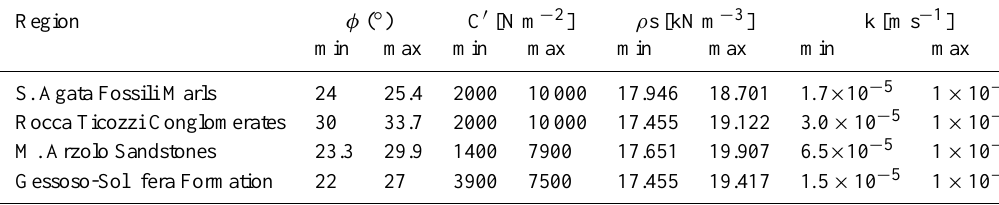
Table 3. Input parameters for the SHALSTAB and TRIGRS models. Region